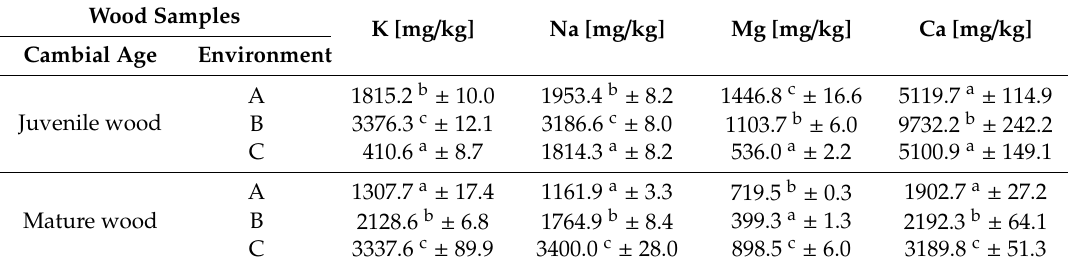
Table 6. Chemical composition of elements (K, Na, Mg, Ca) in lime ( Tilia cordata Mill.) wood. Wood